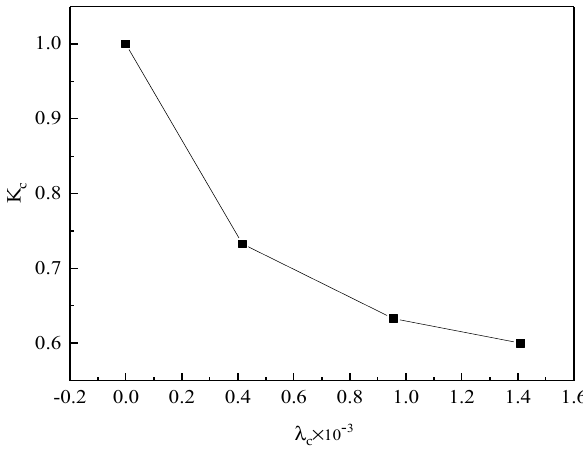
Figure 13. The curve of K c - λ c .